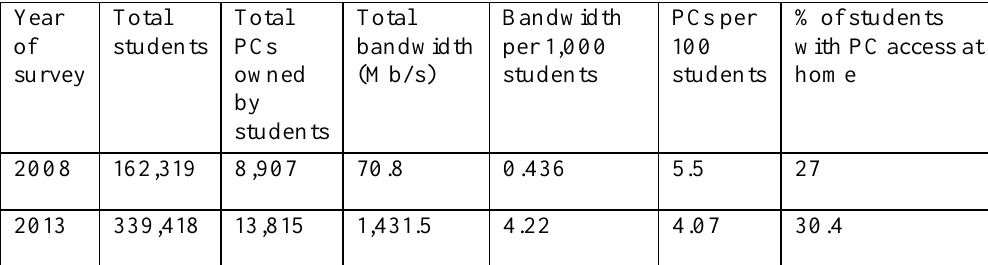
Demographic Data and Internet Availability for 17 Universities in Kenya From 2008-